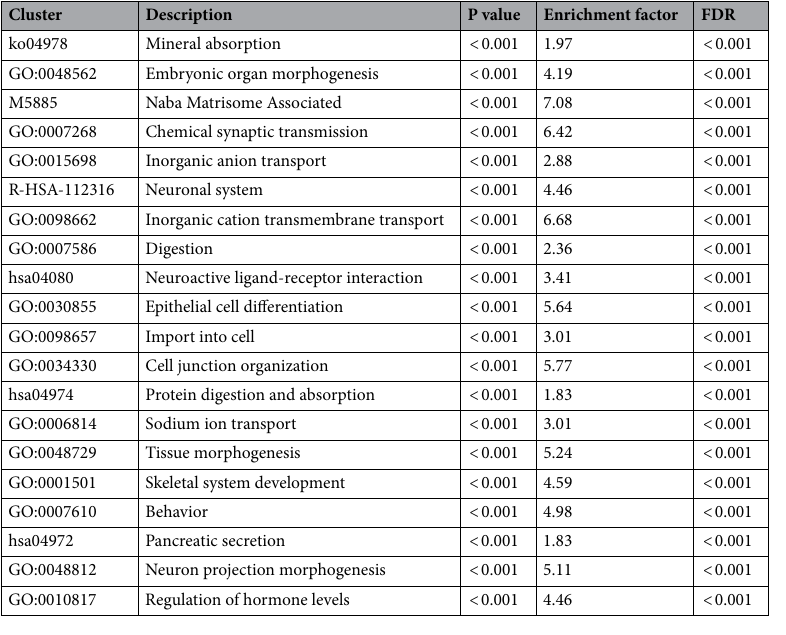
Table 1. Top 20 clusters in pathway and process enrichment analysis of DEGs in LIHC patients with distinct TBC1D1B levels. FDR false discovery